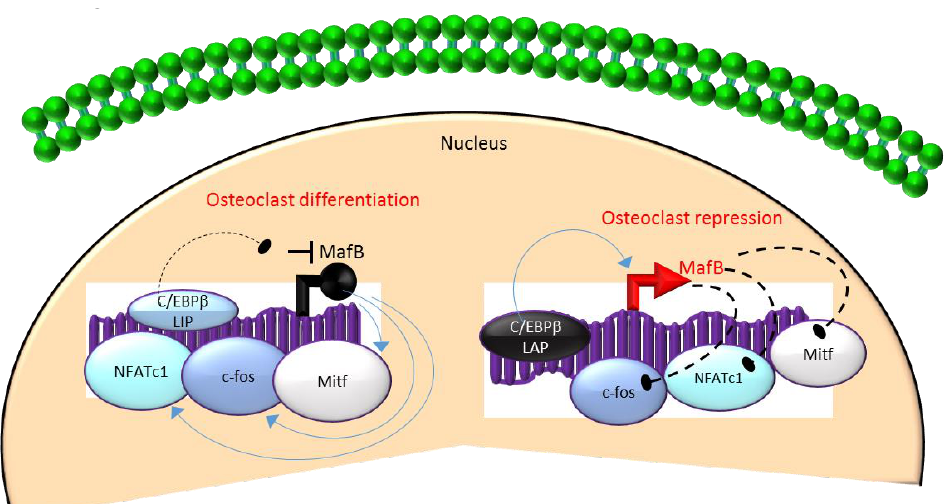
Figure 3. A negative feedback loop between C / EBP β and MafB regulates osteoclastogenesis. C / EBP β is produced as two major isoforms: C / EBP β -LAP (stimulatory) and C / EBP β -LIP (inhibitory) which activate or repress the basic region / leucine zipper transcription factor MafB, respectively. The repression of MafB by LIP induces osteoclast di ff erentiation due to the loss of MafB-mediated repression of NAFTc1, c-fos and Mitf. In contrast, stimulation of MafB expression by LAP blocks osteoclast di ff erentiation due to MafB-mediated repression of NAFTc1, c-fos and Mitf. Blue colored arrow-ended lines: stimulation / activation; Black circle-ended dash lines: inhibition. Red colored pointed arrows: transcriptional activation; Black colored closed circle: transcriptional